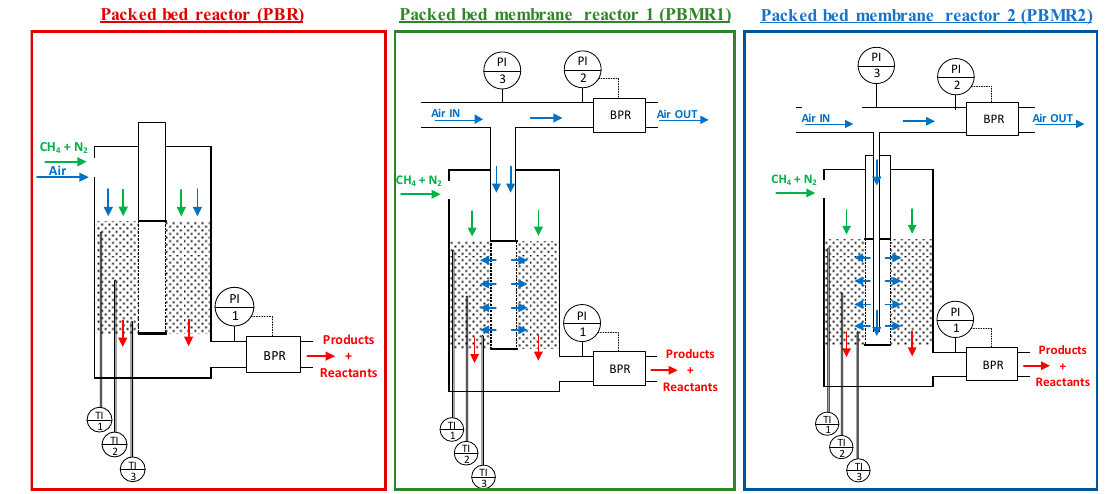
Figure 5. Scheme of the different reactor configurations (packed bed reactor (PBR), packed bed membrane reactor 1 (PBMR), and packed bed membrane reactor 2 (PBMR2)) used for this study.